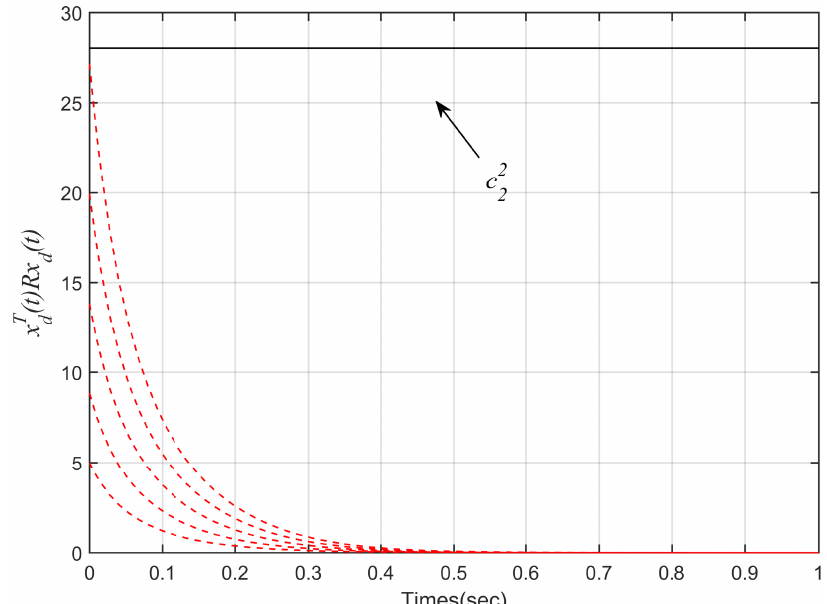
( t ) Rx ( t ) under different initial d d